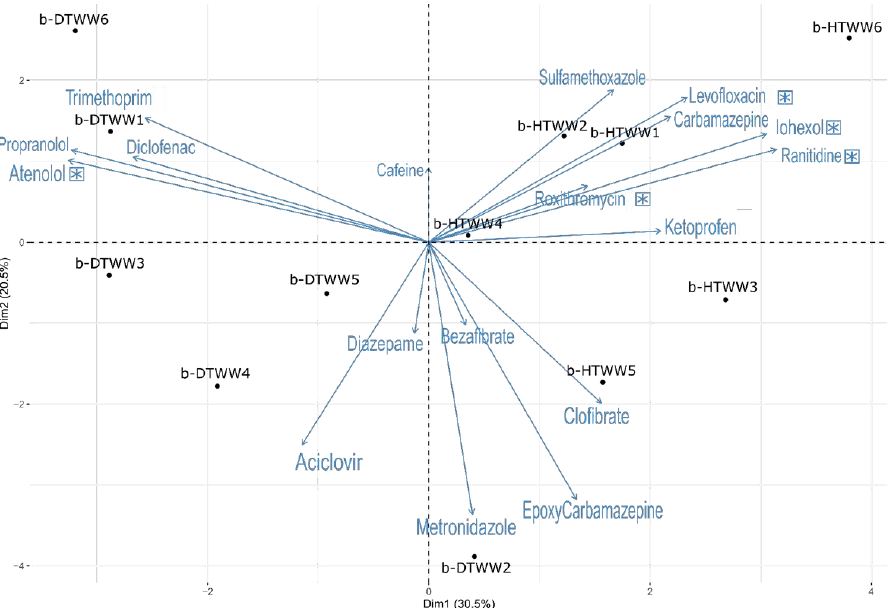
Figure 2. Principal component analysis (PCA) of the 18 pharmaceuticals monitored among the blueschist biofilms developing from clarifier waters (Table S1). The PCA was computed from datasets generated from biofilms recovered from the clarifiers of the domestic (b-DTWW) and hospital (b-HTWW) treatment lines of the SIPIBEL experimental site (Figure 1). Asterisks highlight significant (Wilcoxon non-parametric tests, p < 0.05) differences between the monitored parameters among the b-HTWW and b-DTWW.